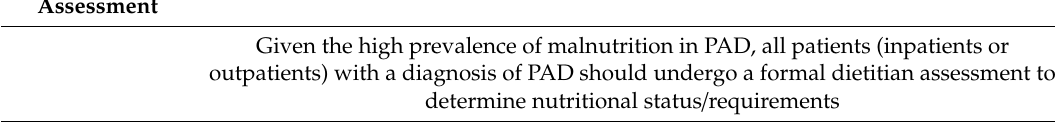
Table 2. Recommendations for the nutritional assessment of patients with Peripheral Arterial Disease to determine their nutritional status and